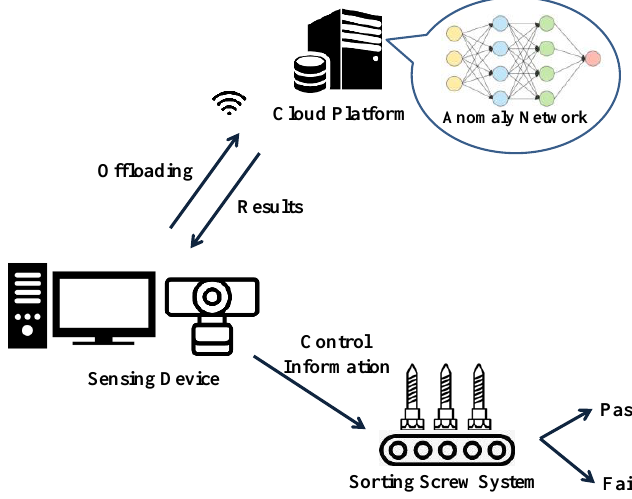
Figure 1. The pipeline of the proposed framework.